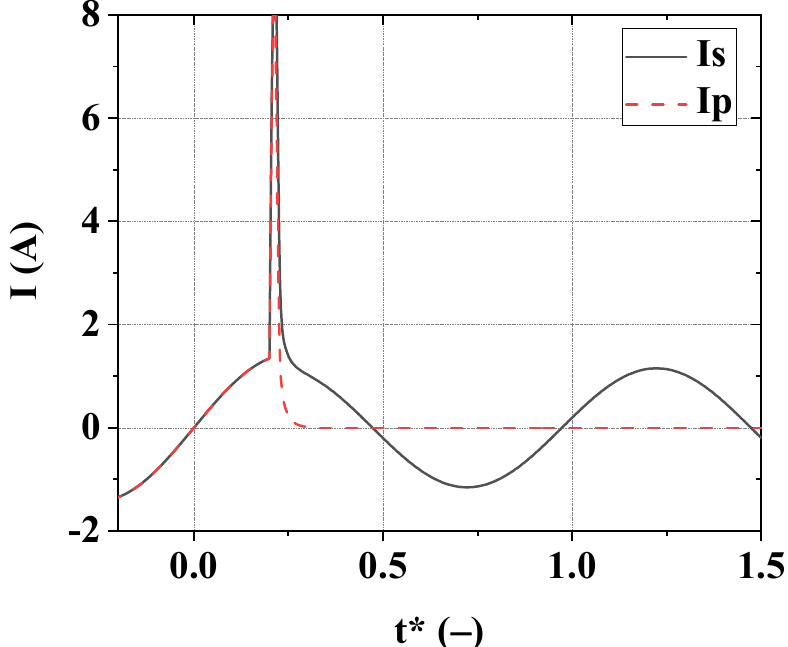
Figure 4. Variation of dimensionless currents of the network I * S = I S / I L (solid line) and fuse box I * F = I F / I L (dashed line) for Cable 2. The dimensionless time is t * = t · f , f = 50 Hz, t * 0SC = 0.2. All the data given are obtained for short-circuit starting moment t * 0SC = 0.2. This value